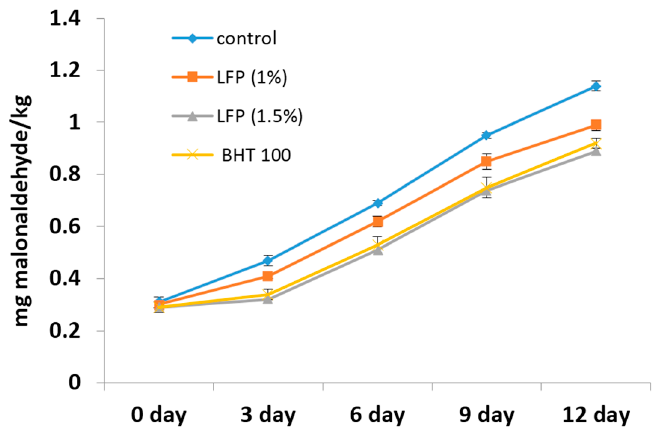
Figure 4. Thiobarbituric acid reactive substance values in sheep meat nuggets with litchi fruit pericarp extracts and BHT during refrigerated storage (4 ± 1 °C).